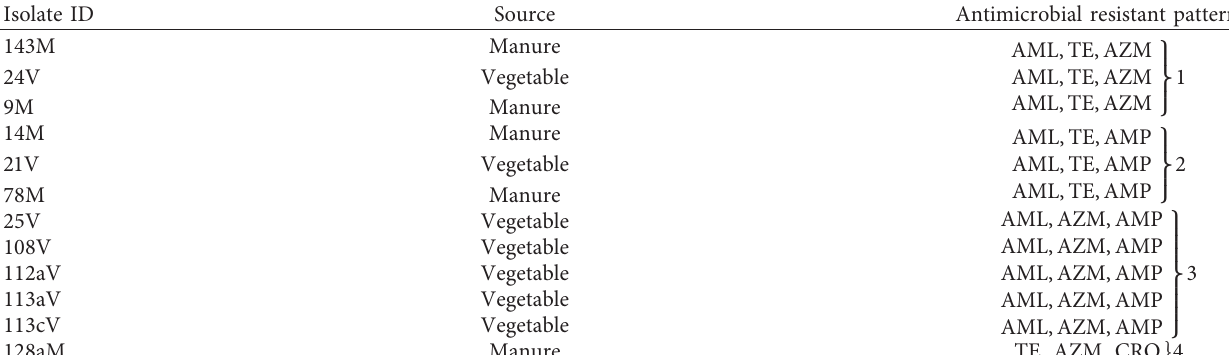
Table 3: Multidrug resistance patterns of NSF E. coli isolates.